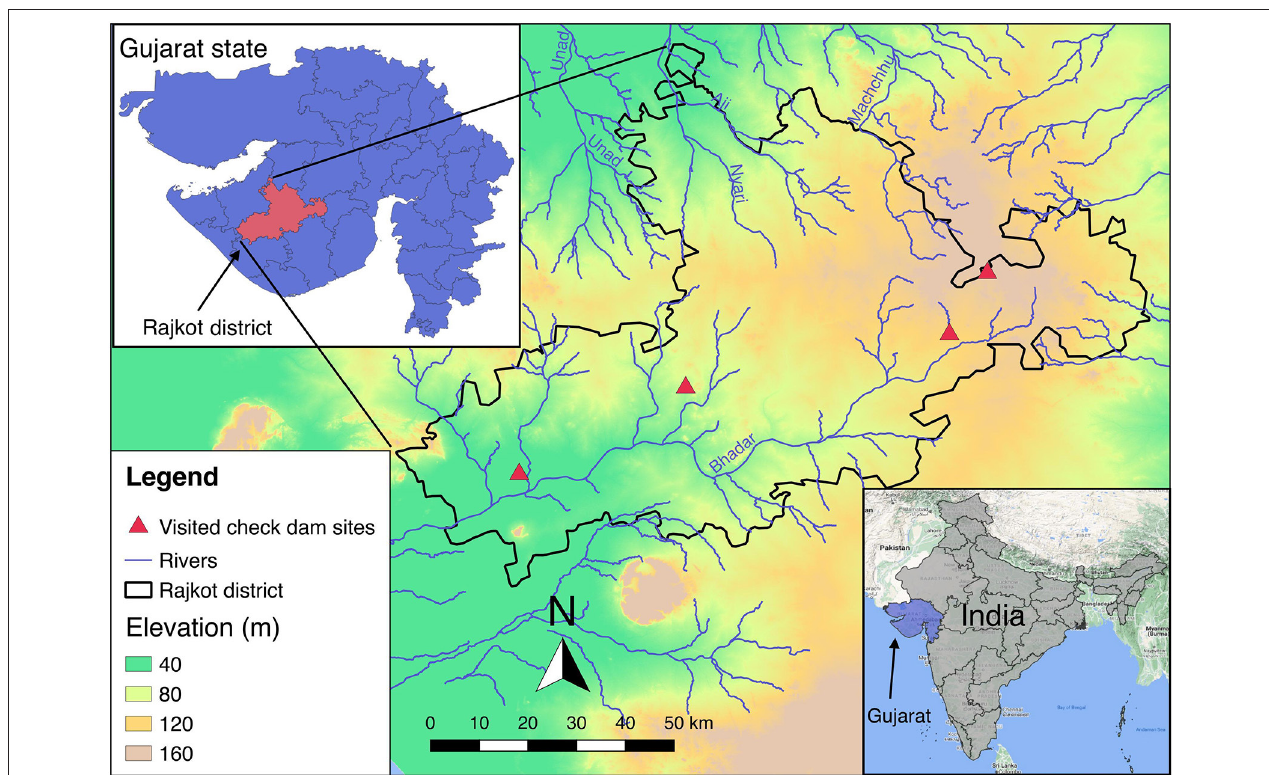
FIGURE 5 | Location of the case-study area, Rajkot district, situated in the state of Gujarat, India. Topographic elevation, main rivers, and the sites where check dams were investigated are